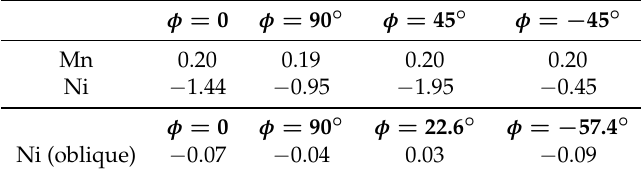
Table 2. Magnetocrystalline anisotropy energies (MAEs, in meV) for Mn– and Ni–TCNQ calculated as the difference MAE = E tot ( 0,0 ) − E tot ( 90 ◦ , φ ) , where the two values in parenthesis are the polar and azimuthal angles, respectively, defining the magnetization direction. Positive (negative) energies indicate in-plane (out-of-plane) anisotropy. The last line corresponds to the oblique cell Ni–TCNQ model with angle γ = 77.43 ◦ , where the anisotropies at the directions of the long (short) pair of Ni–N bond directions are shown. The table values have been obtained for U = 4 eV with an energy cutoff of 400 eV and a 12 × 18 × 1 k-point sampling, using the tetrahedron method for integration. φ = 0 φ = 90 ◦ φ = 45 ◦ φ = − 45 ◦ Mn 0.20 0.19 0.20 0.20 Ni − 1.44 − 0.95 − 1.95 − 0.45 φ = 0 φ = 90 ◦ φ = 22.6 ◦ φ = − 57.4 ◦ Ni (oblique) − 0.07 − 0.04 0.03 −